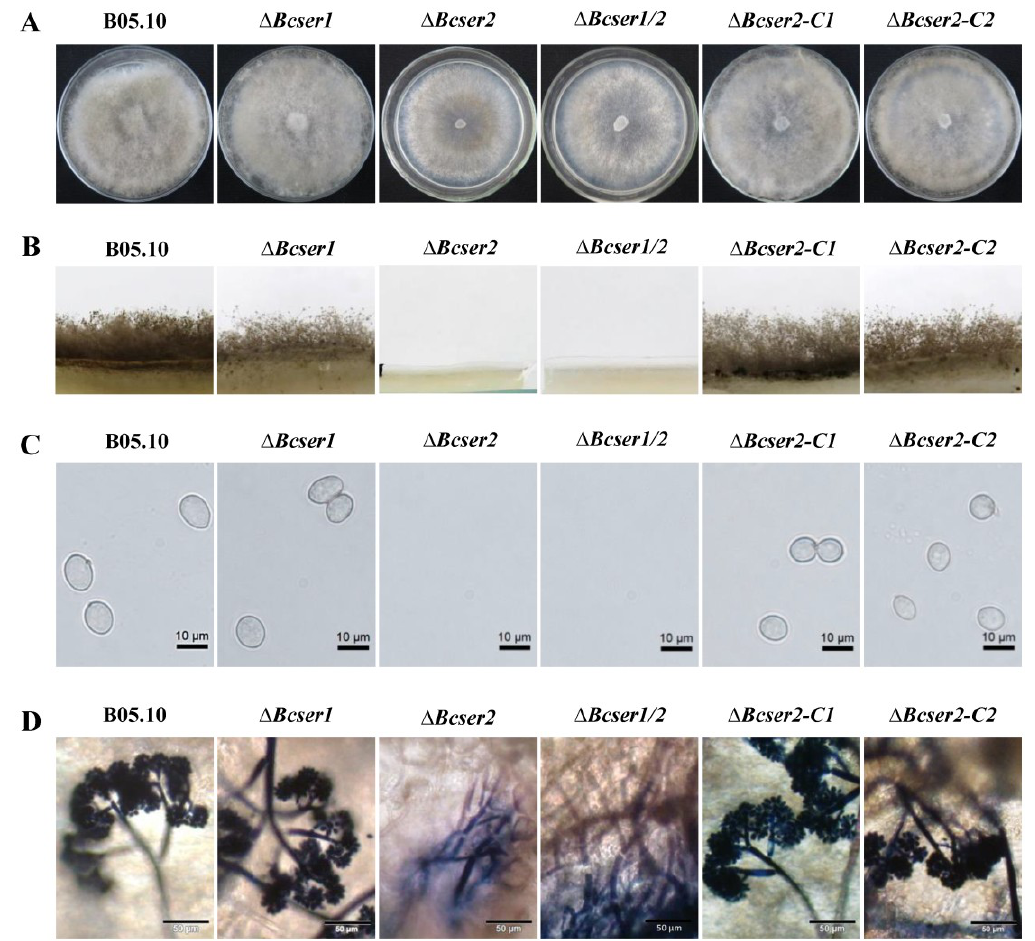
Figure 3. Effects of Bcser1 and Bcser2 deletion on conidiophore and conidia development of B. cinerea . ( A ) Phenotype of mutants and wild-type strain B05.10 grown on potato dextrose agar (PDA) medium at 20 °C under a 12 h light/dark cycles. Photographs were captured at 14 days post-inoculation (dpi). ( B ) Production of conidiophores on PDA medium at 20 °C under a 12 h light/dark cycles. ( C ) Conidiation of deletion mutants ∆Bcser1 , ∆Bcser2 and ∆Bcser1 / 2 , complemented mutants ∆Bcser2-C1 and ∆Bcser2-C2 , and wild-type strain B05.10 grown on PDA medium at 20 °C under continuous light. Scale bar, 10 µm. ( D ) Production of conidiophores on wounded Arabidopsis leaves. Scale bar, 50 µm. 2.3. Bcser2 Is Essential for the Full Virulence of B. cinerea